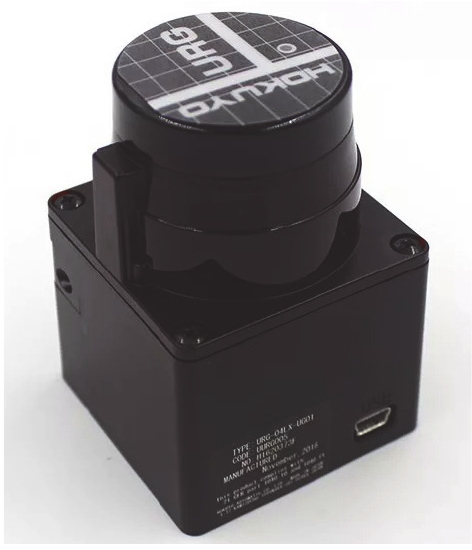
Figure 2. LRF URG ‐ 04LX ‐ UG01 by Hokuyo Automatic Co. Figure 2. LRF URG-04LX-UG01 by Hokuyo Automatic